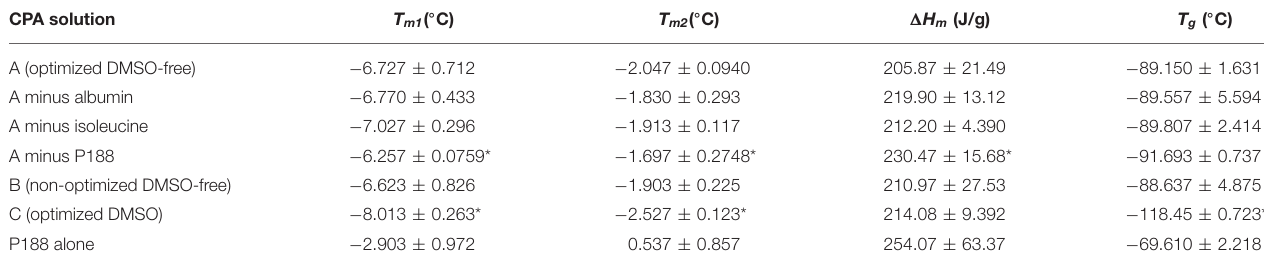
TABLE 4 | Melting temperatures, enthalpy of melting, and glass transition temperatures for DMSO-free and DMSO CPA solutions measured by DSC a